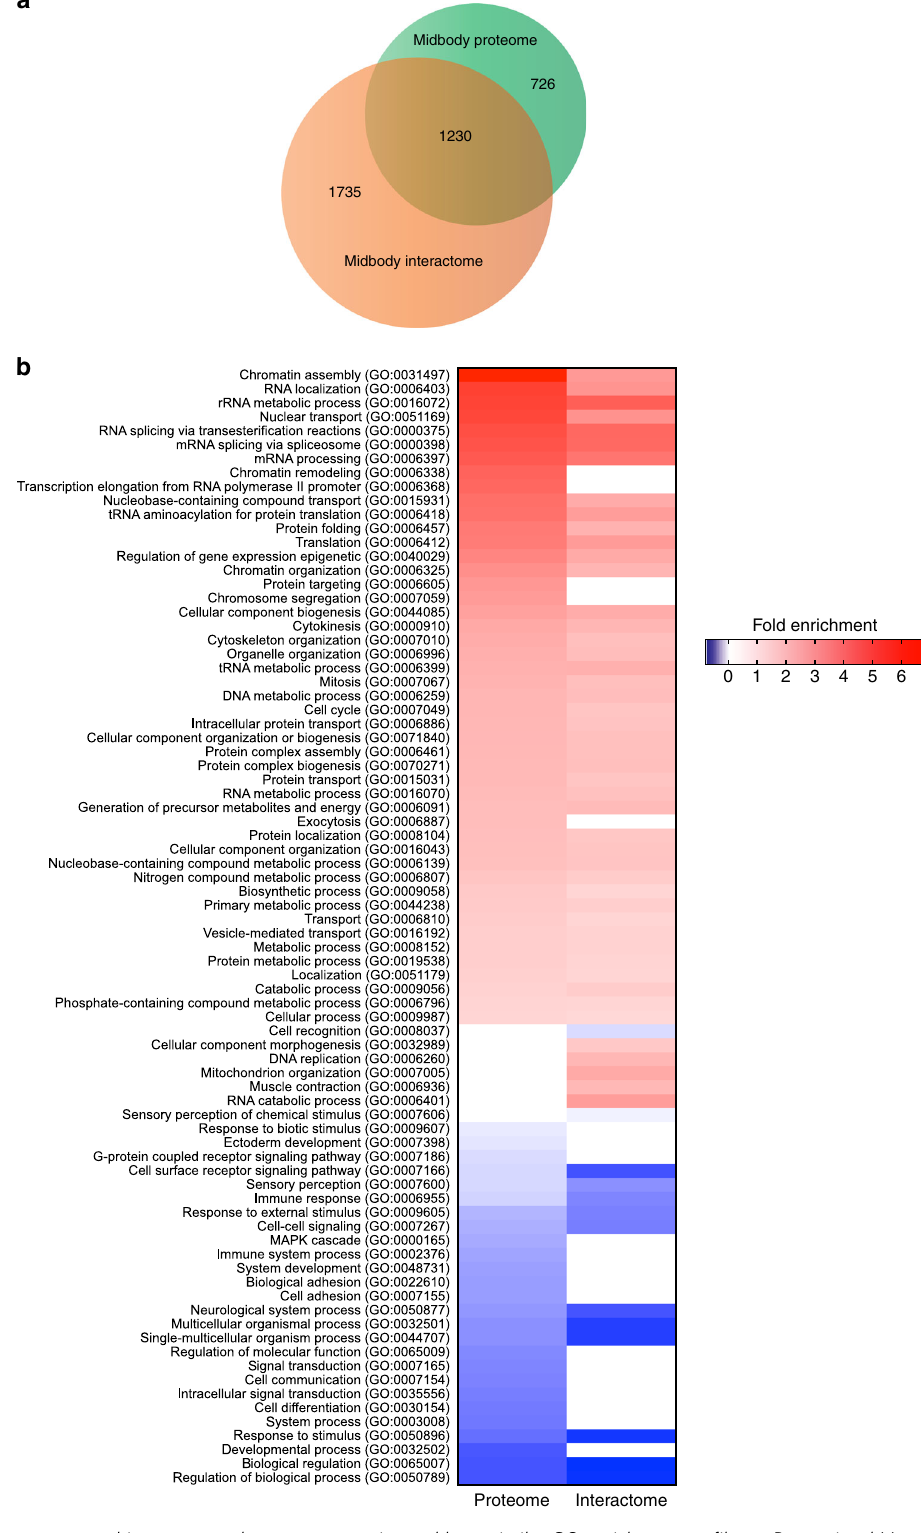
Fig. 2 The midbody proteome and interactome share many proteins and have similar GO enrichment pro fi les. a Proportional Venn diagram showing the number of proteins identi fi ed in the midbody proteome and interactome. The majority of midbody proteome proteins (62.9%) are contained in the midbody interactome. b Heat map showing the GO annotation enrichment pro fi les of the midbody proteome and of the midbody interactome. GO enrichment pro fi les were analyzed using PANTHER under the category GO-slim biological process. Overrepresented GO terms are shown in shades of red while underrepresented GO terms are shown in shades of blue, according to their fold enrichment as indicated in the color scale bar at the right. Only Bonferroni-corrected results for p < 0.05 were considered (see Supplementary Data